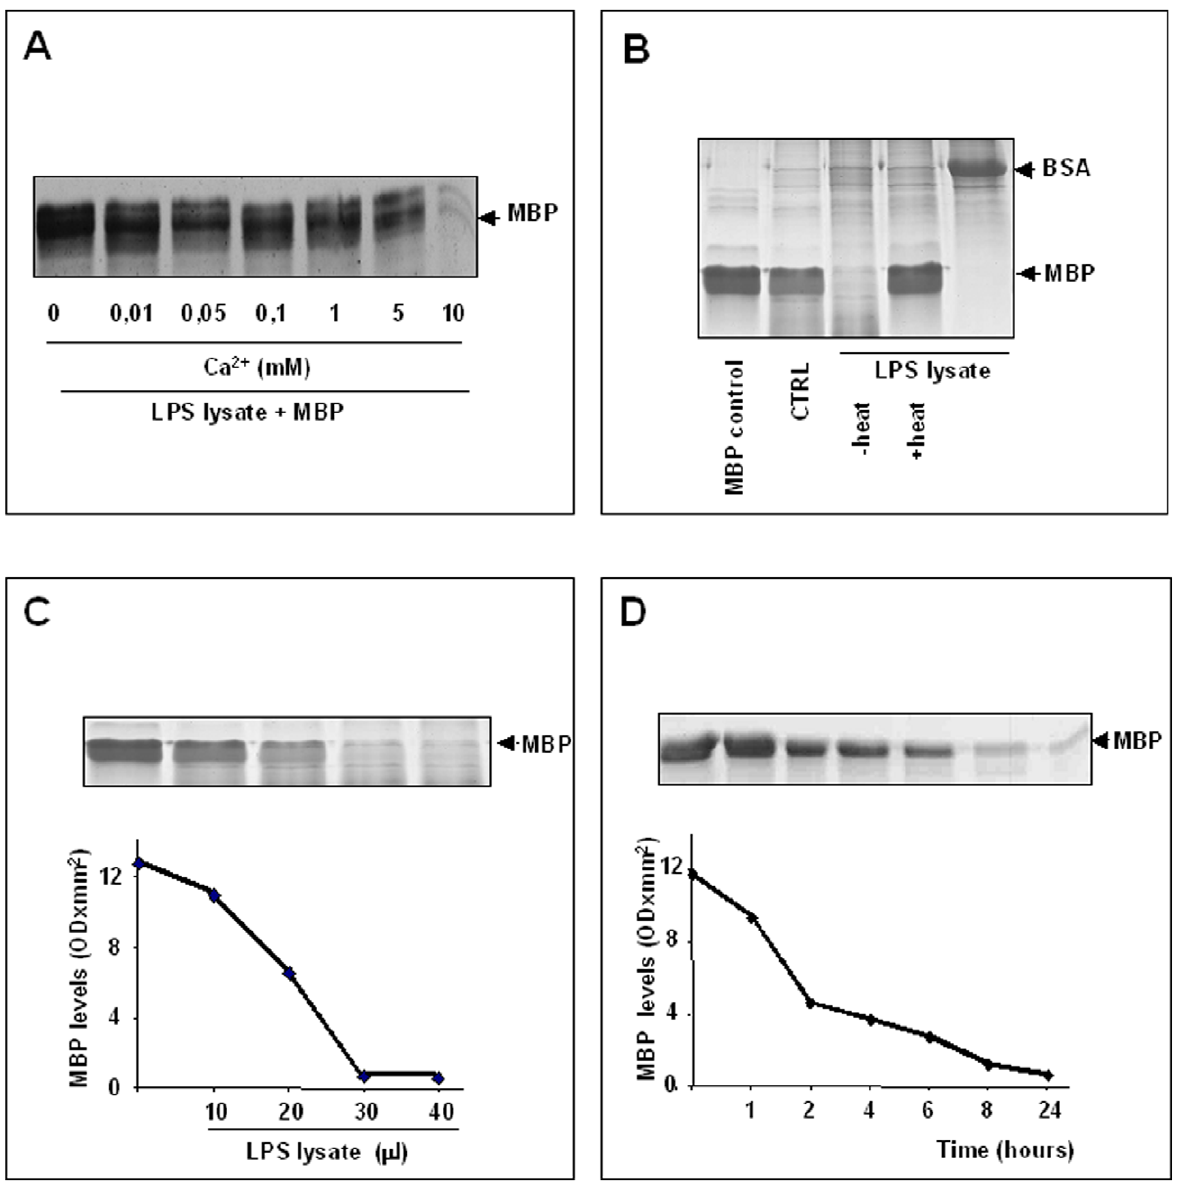
Figure 1. Degradation of MBP by proteolytic activities present in astrocyte lysates. Lysates from LPS-activated astrocytes were incubated with exogenous MBP, then subjected to SDS-PAGE as described in text. As controls, MBP was incubated without cell lysate (MBP control) or with lysate from unactivated astrocytes (CTRL). A, Calcium dependency of MBP degradation. B, Substrate specificity of proteolytic activity present in LPS- activated lysates towards MBP. C, Dose-dependent degradation of MBP by LPS-activated lysates from astrocytes after incubation at 37 u C for 24 h. D, Time-course of the MBP degradation by 30 m l of LPS-activated lysate. In the lower part of C and D MBP degradation is expressed as optical density (OD 6 mm 2 ) as calculated by densitometrical analysis of